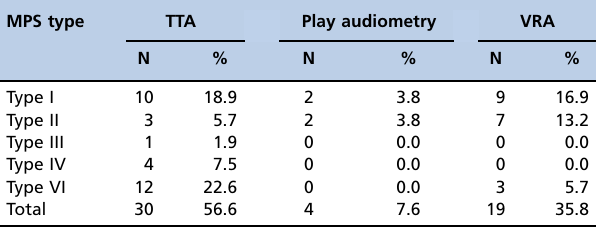
Table 1 - Occurrence of procedures per type of MPS (N=53).